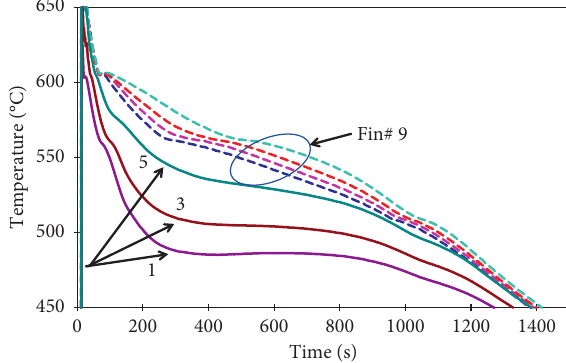
Figure 3: Solidification time for each fin.